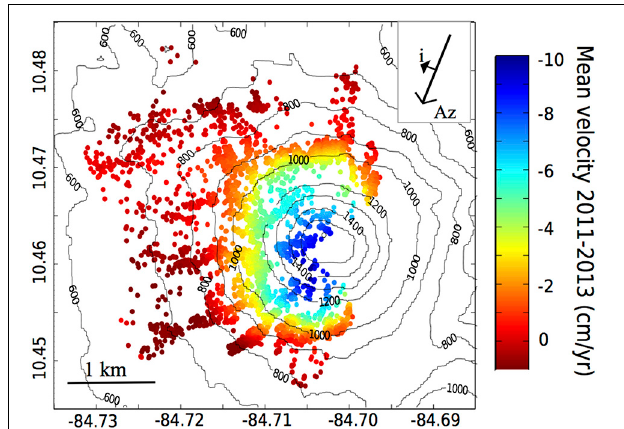
FIGURE 3 | Mean line-of-sight velocities found from persistent scatterer analysis between 24.06.2011 and 15.09.2013. Azimuth (Az) direction = − 167 ◦ , incidence angle (i) = 37 ◦